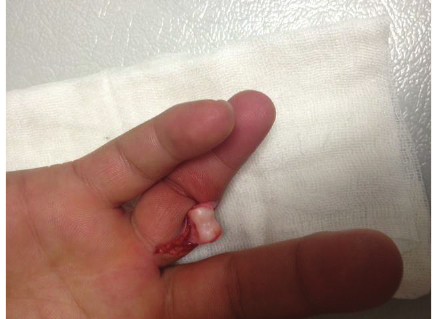
Figure 1: Injury showing open finger dislocation.